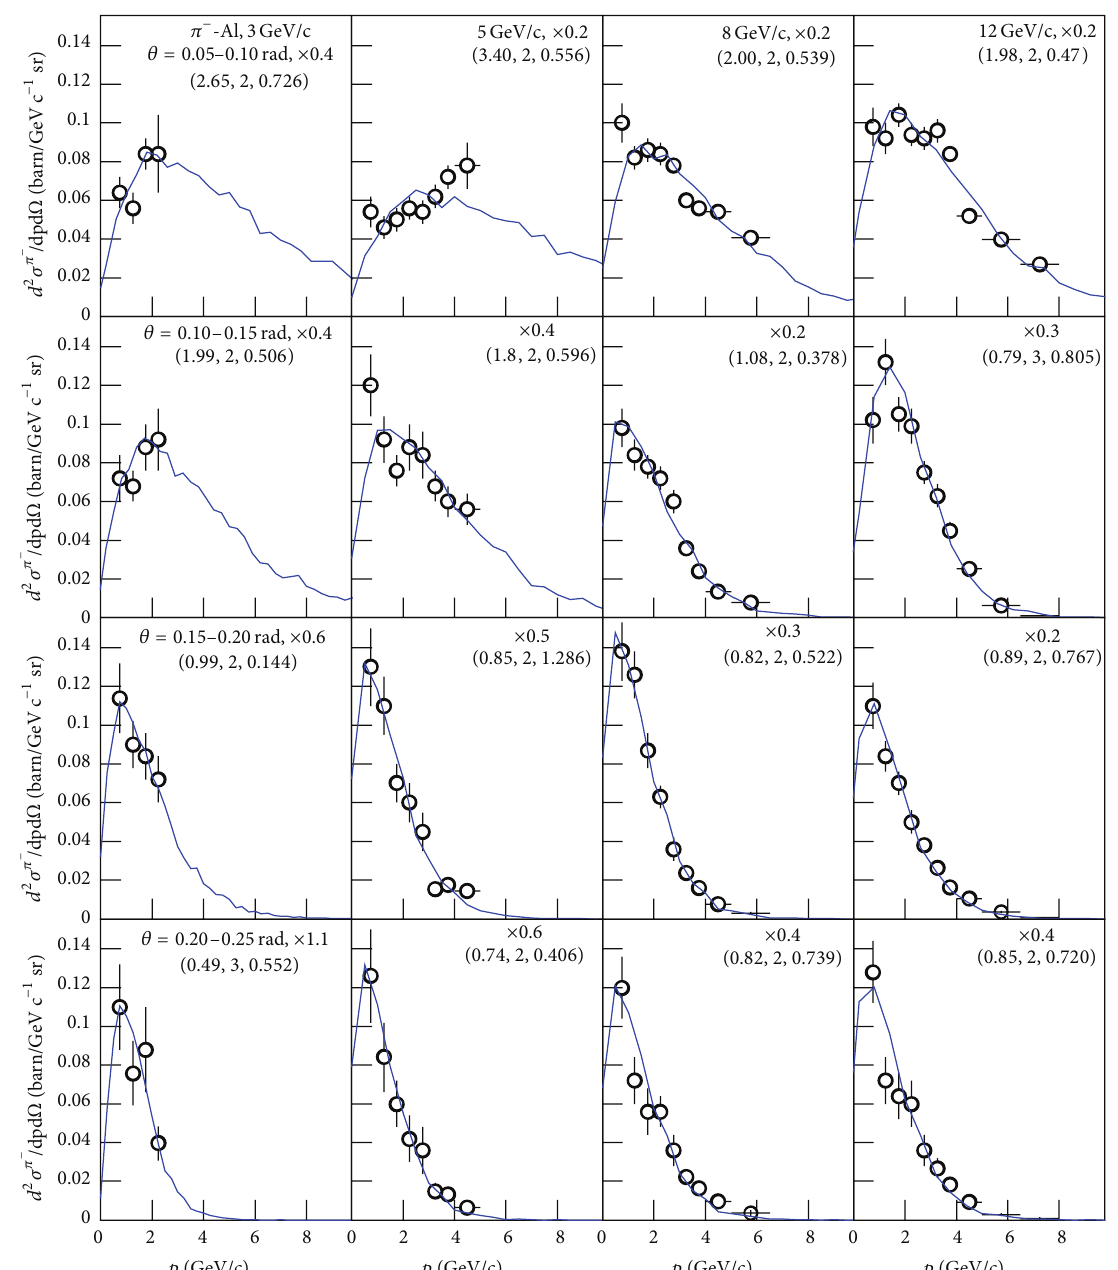
Figure 10: The same as Figure 1, but showing the results for 𝜋 − production cross sections in 𝜋 − -Al interactions.